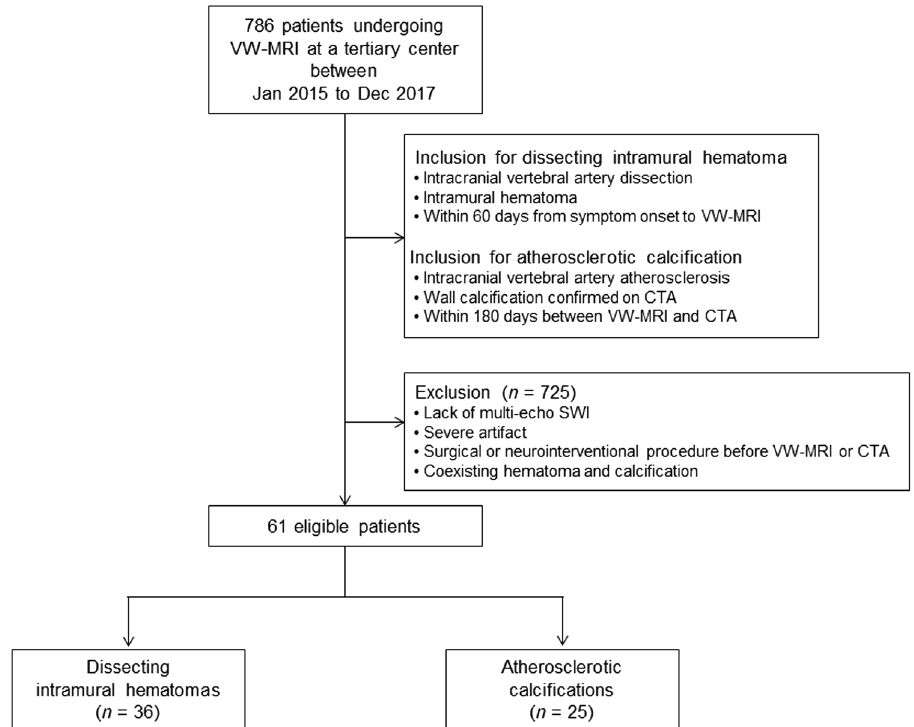
Figure 4. Flowchart of